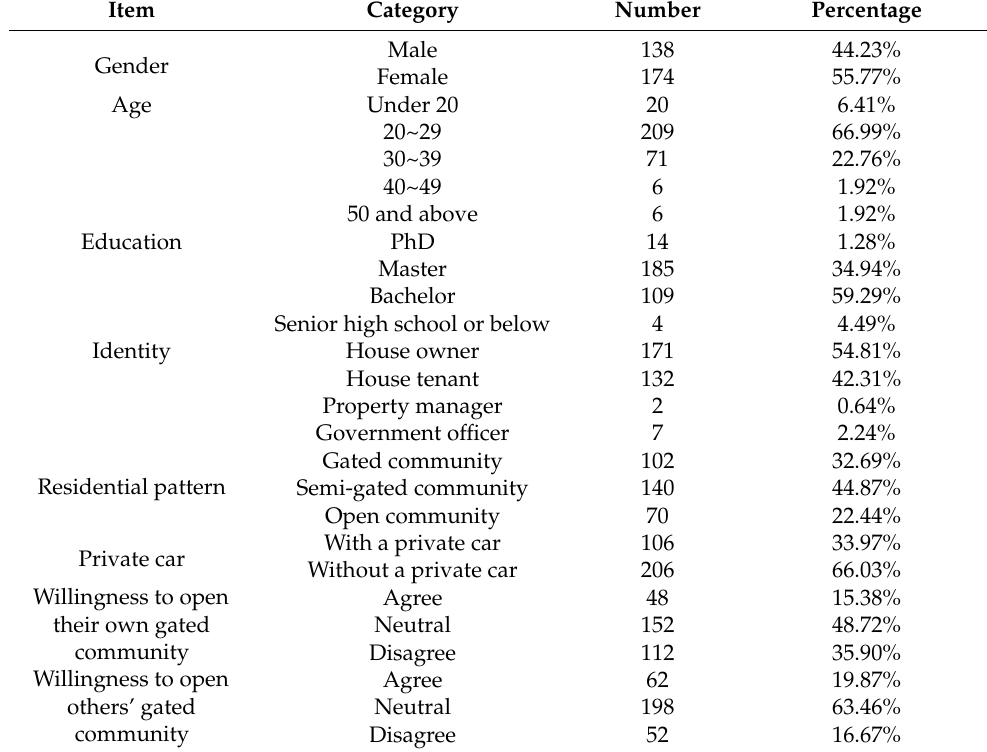
Table 2. Basic information of respondents.